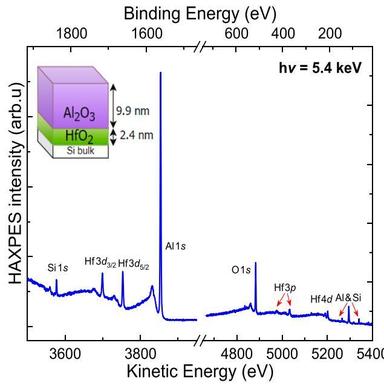
Cr Kα HAXPES spectrum of buried HfO2 with Al2O3 overlayer. The left side of the spectrum contains high energy transitions which are not available with an Al Kα X-ray source.